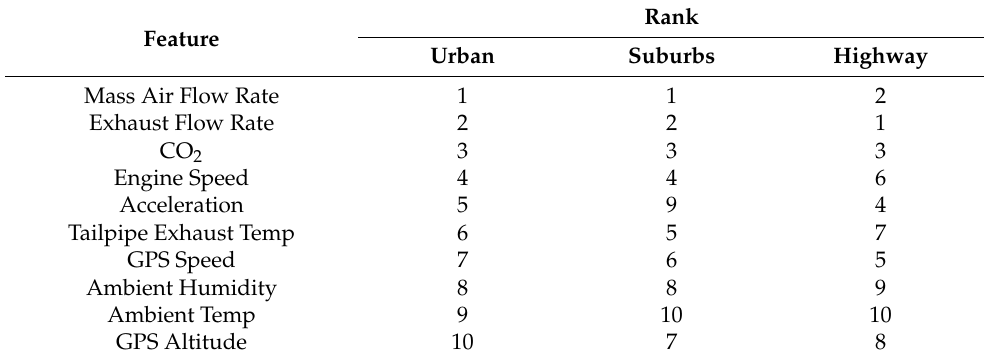
Table 7. Feature importance rank of NO x model in urban, suburbs, and highway.